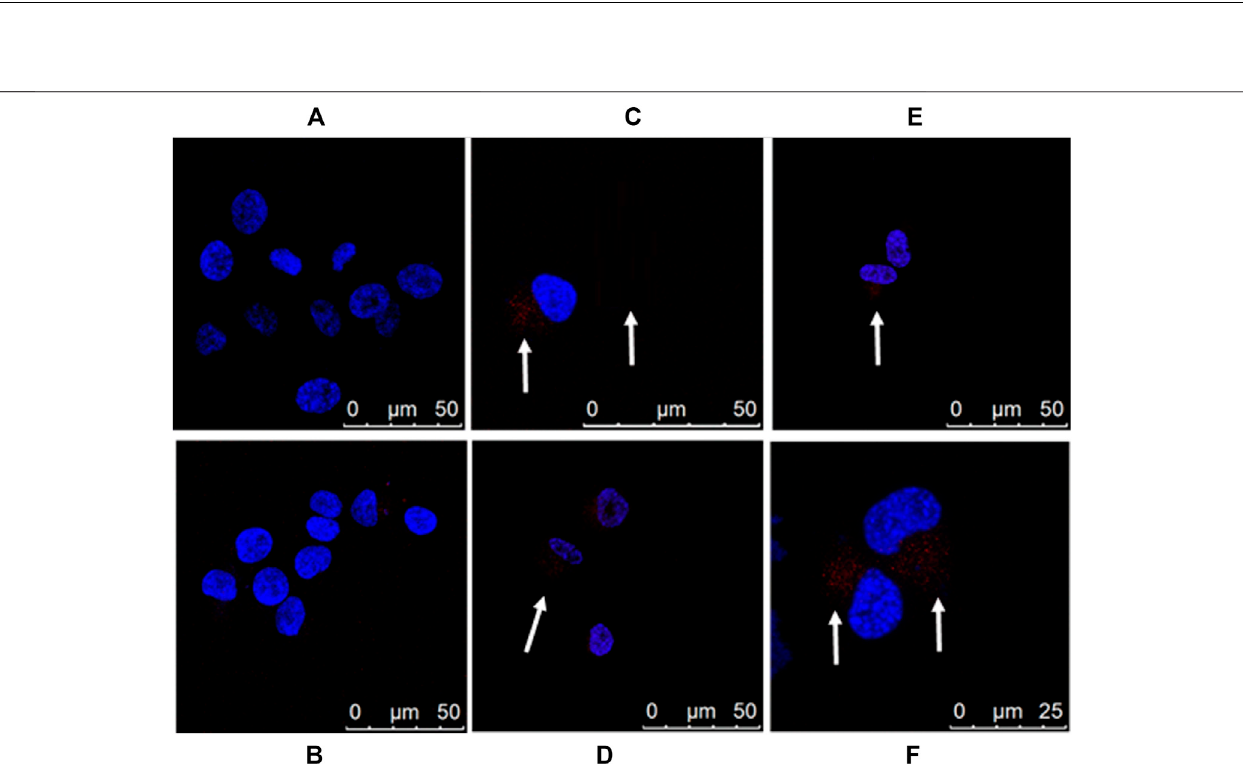
FIGURE9| Imaging ofU87MG cells byAPTSAP-protoporphyrin IX. U87MG cells were incubated for 2 h with5 µM APTSAP-PPIXcomplexes and 5 µM PPIX (see Materials and Methods ) and observed under a fl uorescence microscope. The strong fl uorescence signal observed after APTSAP treatment was indicative of PPIX binding to G-quadruplex AS1411 conformation inside the plasmid vector. (A) control; (B) PPIX; (C)